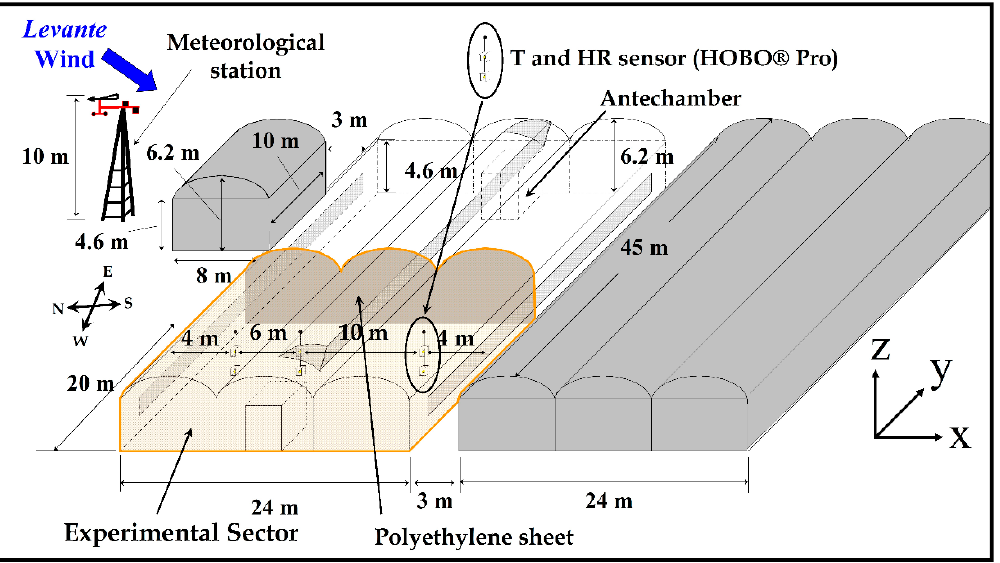
Figure 1. Sketch of the halved greenhouse for the experimental tests.